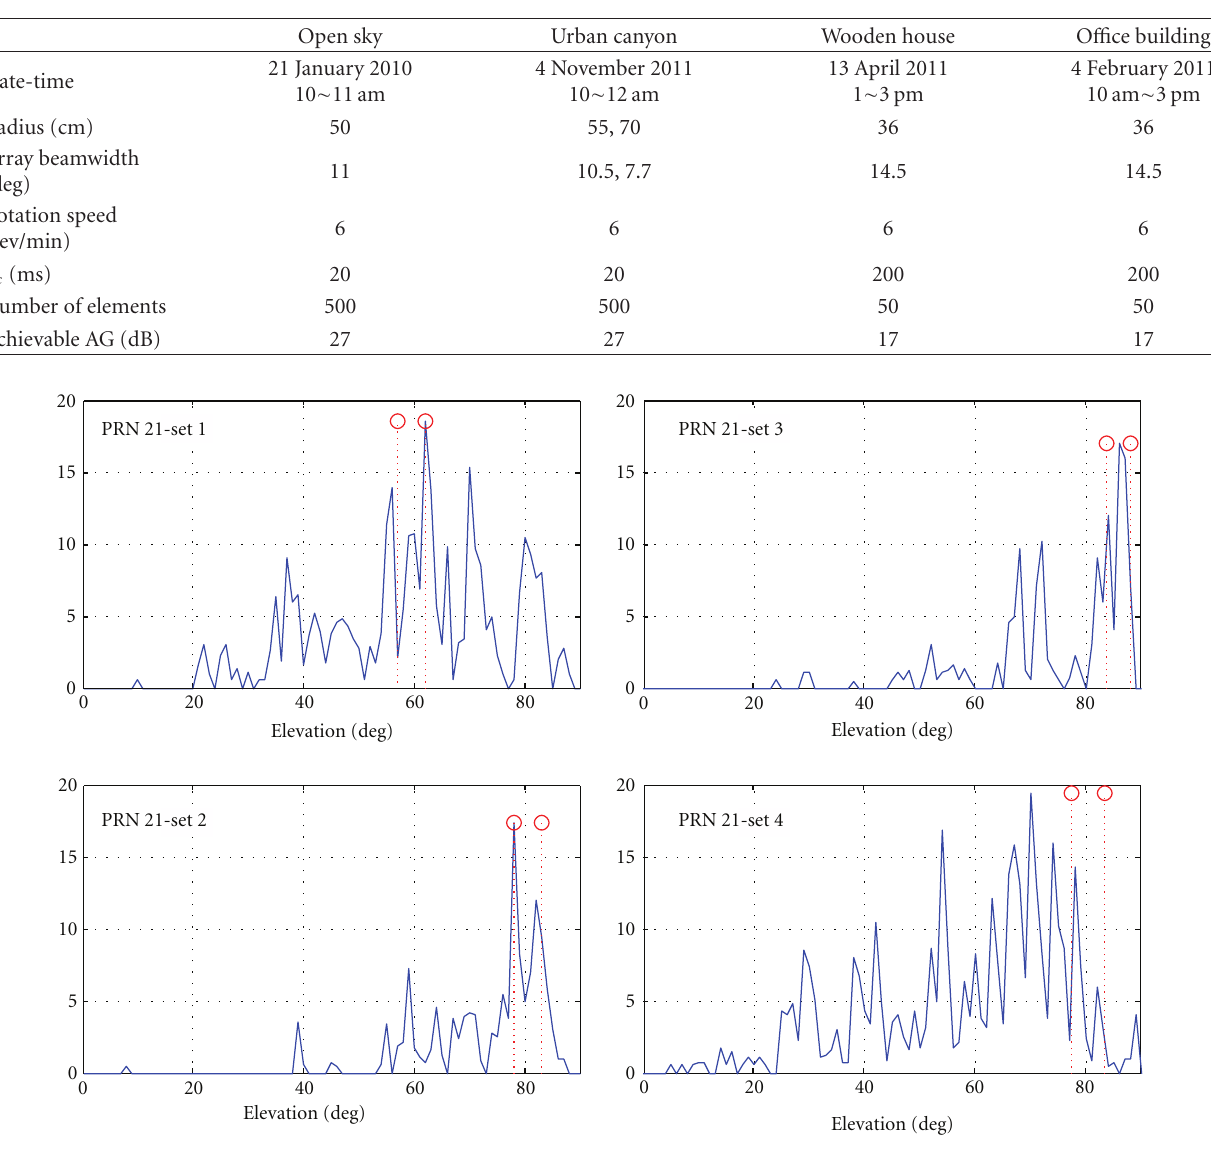
Table 1: Technical and general specification of data collection.